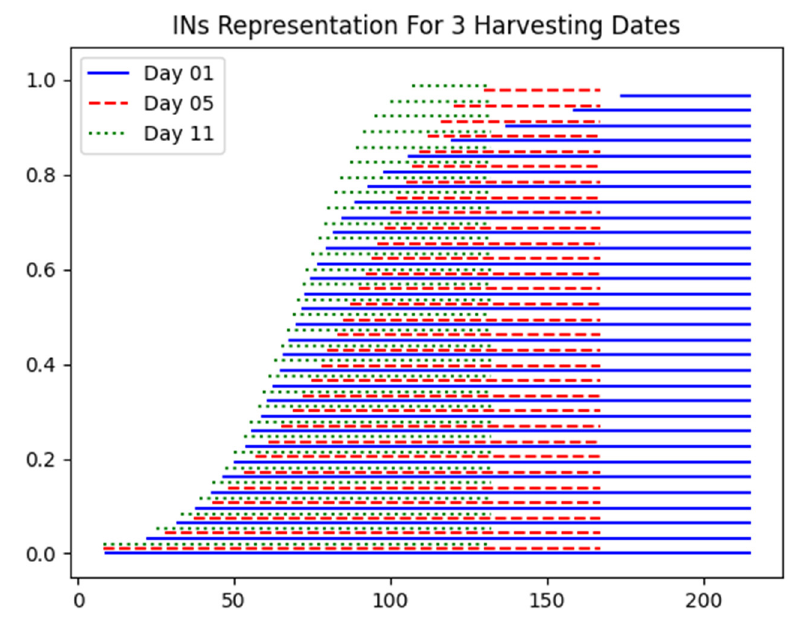
Figure 3. Interval-representation of INs computed from histograms in Figure 2.